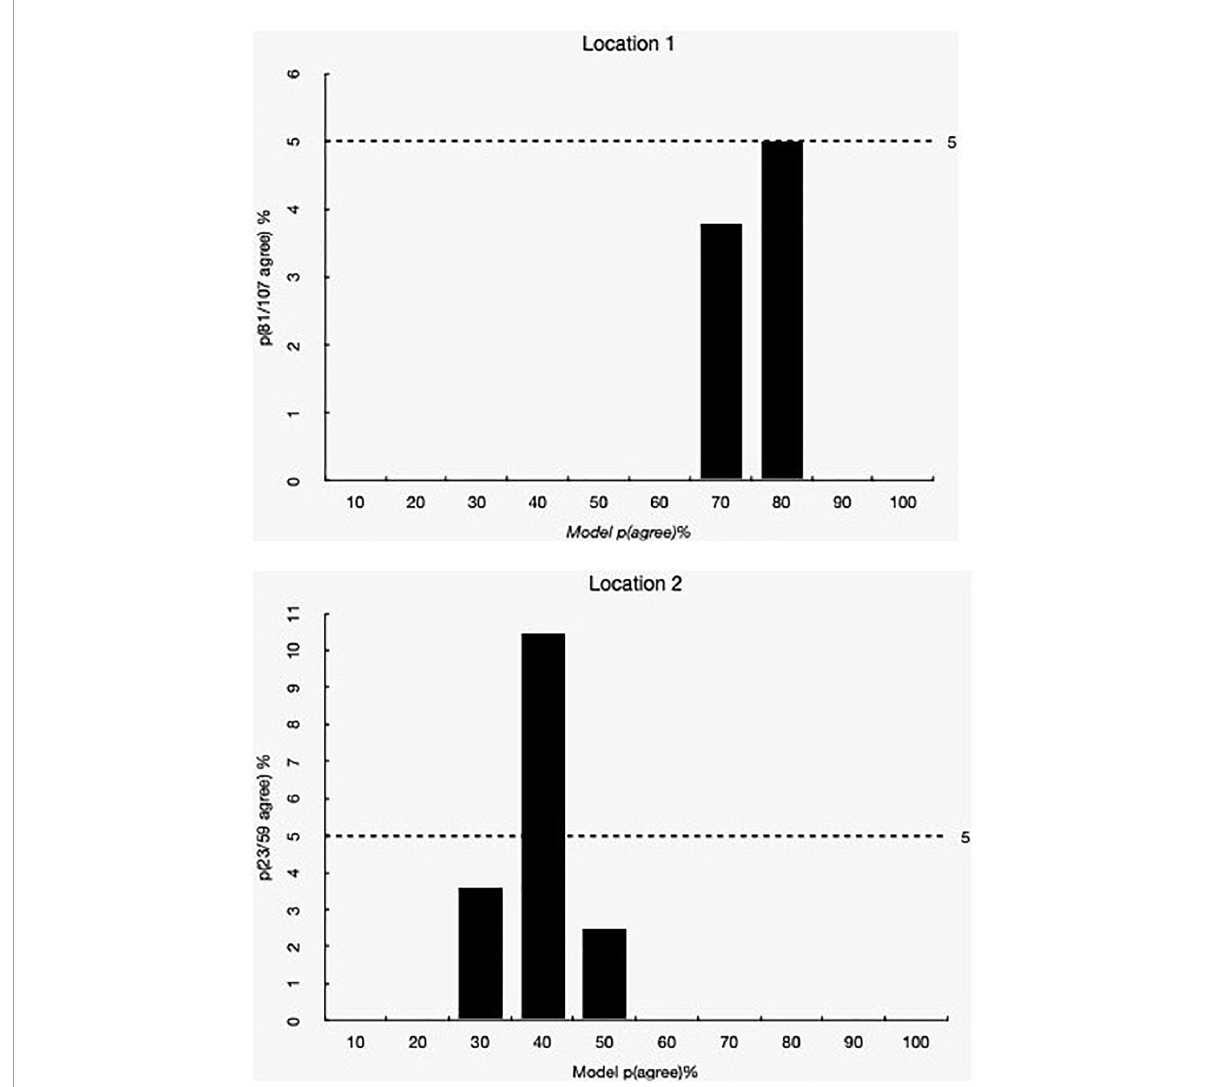
FIGURE1 Probability mass of binomial distribution of agreement with the reduction of the APM at locations 1 (A) and 2 (B)